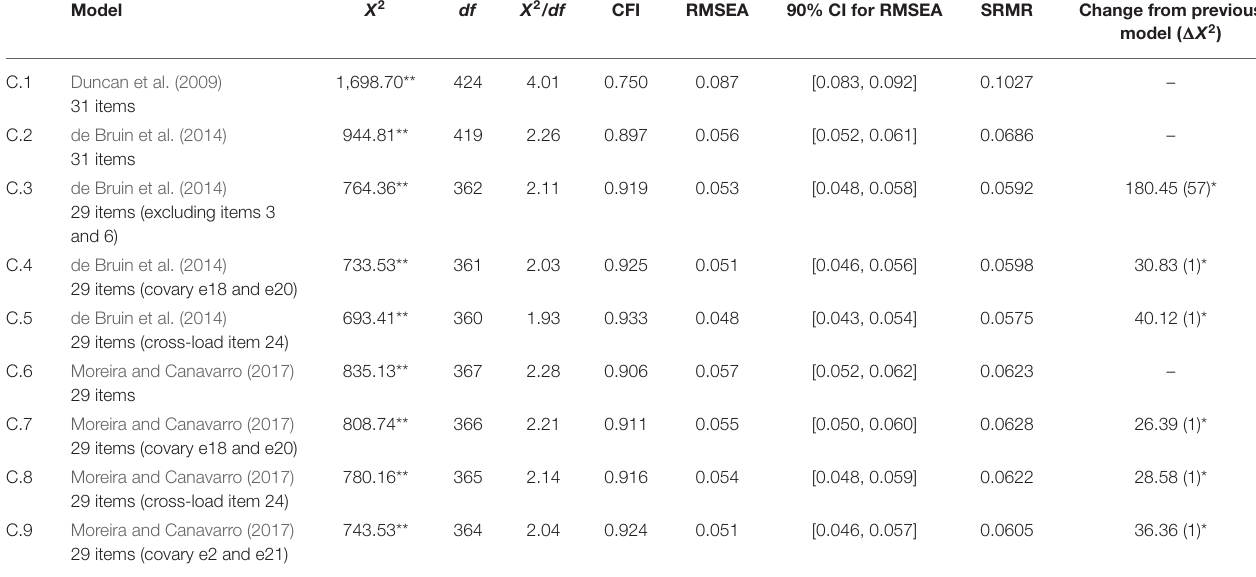
TABLE 2 | Fit indices from the confirmatory factor analyses, for mothers of children ( n = 396). Model